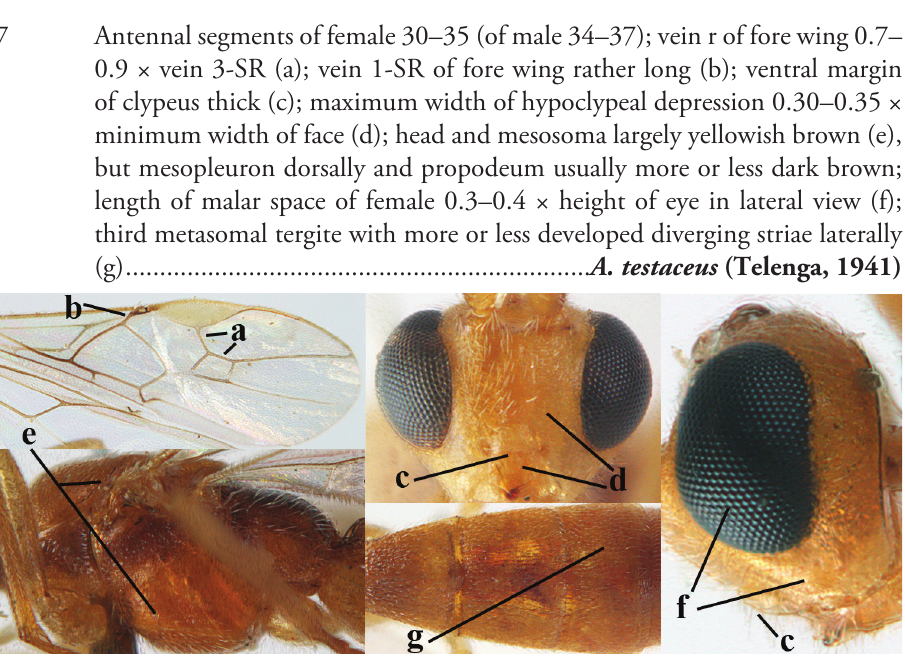
– Antennal segments of both sexes (37–)40–45(–47); vein r of fore wing 0.5–0.6 × vein 3-SR (aa); vein 1-SR of fore wing shorter (bb); ventral mar- gin of clypeus thin (cc); maximum width of hypoclypeal depression about 0.5 × minimum width of face (dd); head and mesosoma largely blackish (ee); length of malar space of female 0.5–0.6 × height of eye in lateral view (ff); third tergite without distinct striae (gg) ........ A. modestus (Reinhard, 1863)